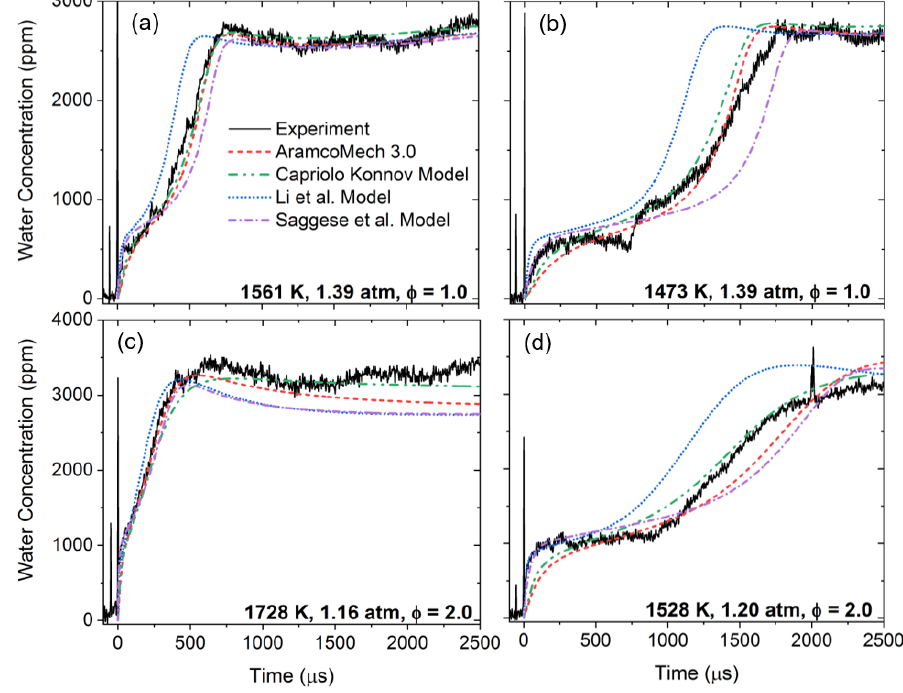
Figure 4. Water time-history results for isopropanol oxidation at ϕ = 1.0 ( a , b ) and 2.0 ( c , d ) around 1.3 atm for high- ( a , c ), and low-temperature ( b , d ) cases. Predictions by the four chemical kinetic models are also shown for comparison.